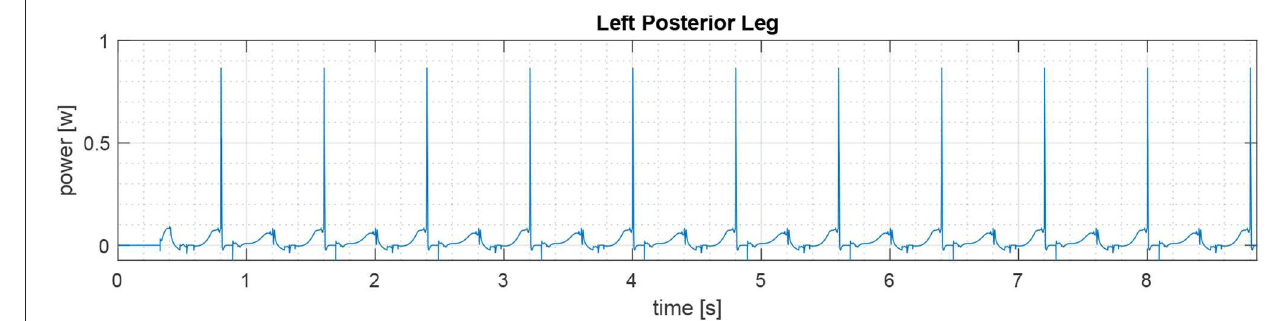
FIGURE 11 | Legs posterior power, TEST 1.